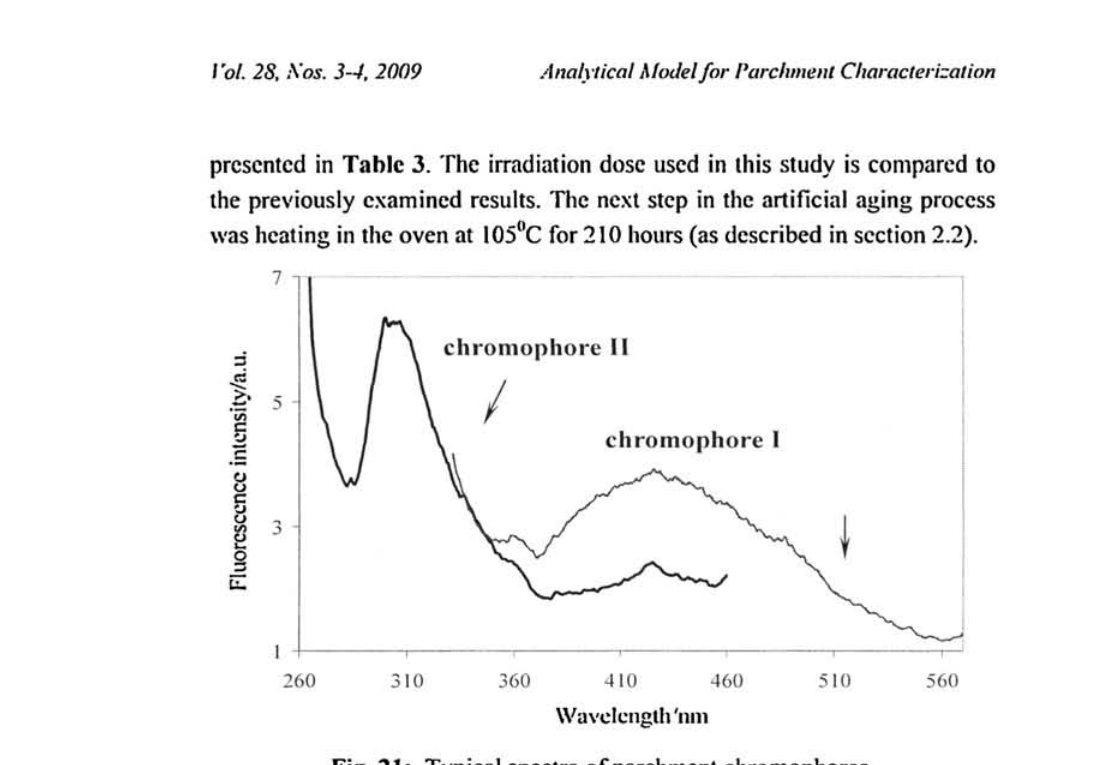
Fig. 21: Typical spectra of parchment